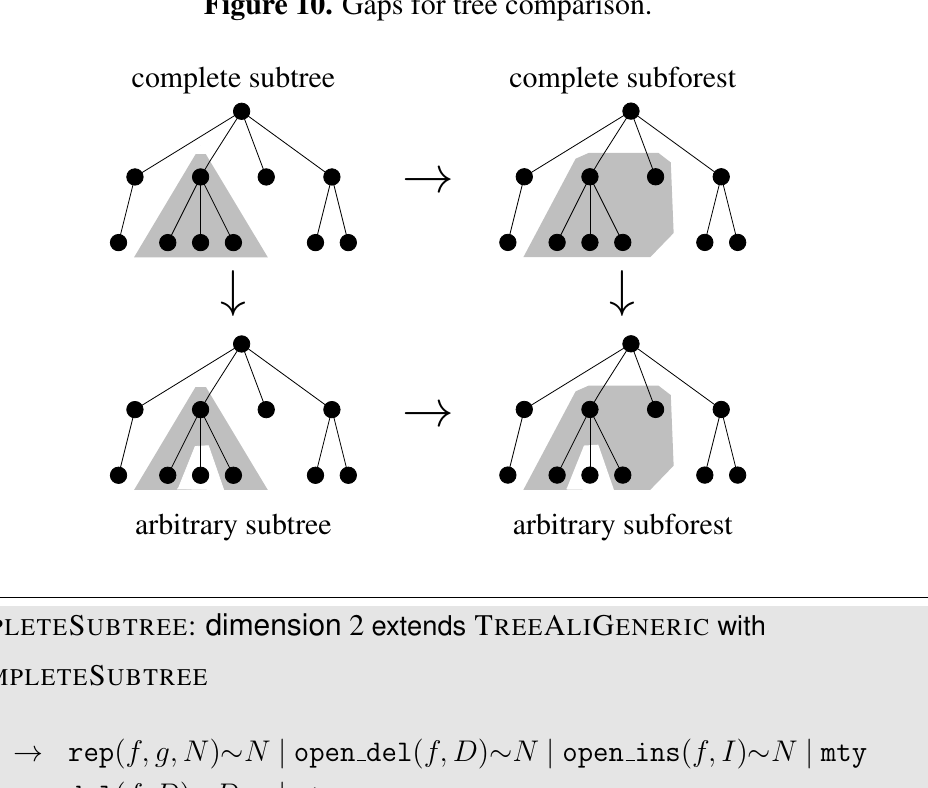
Figure 10. Gaps for tree